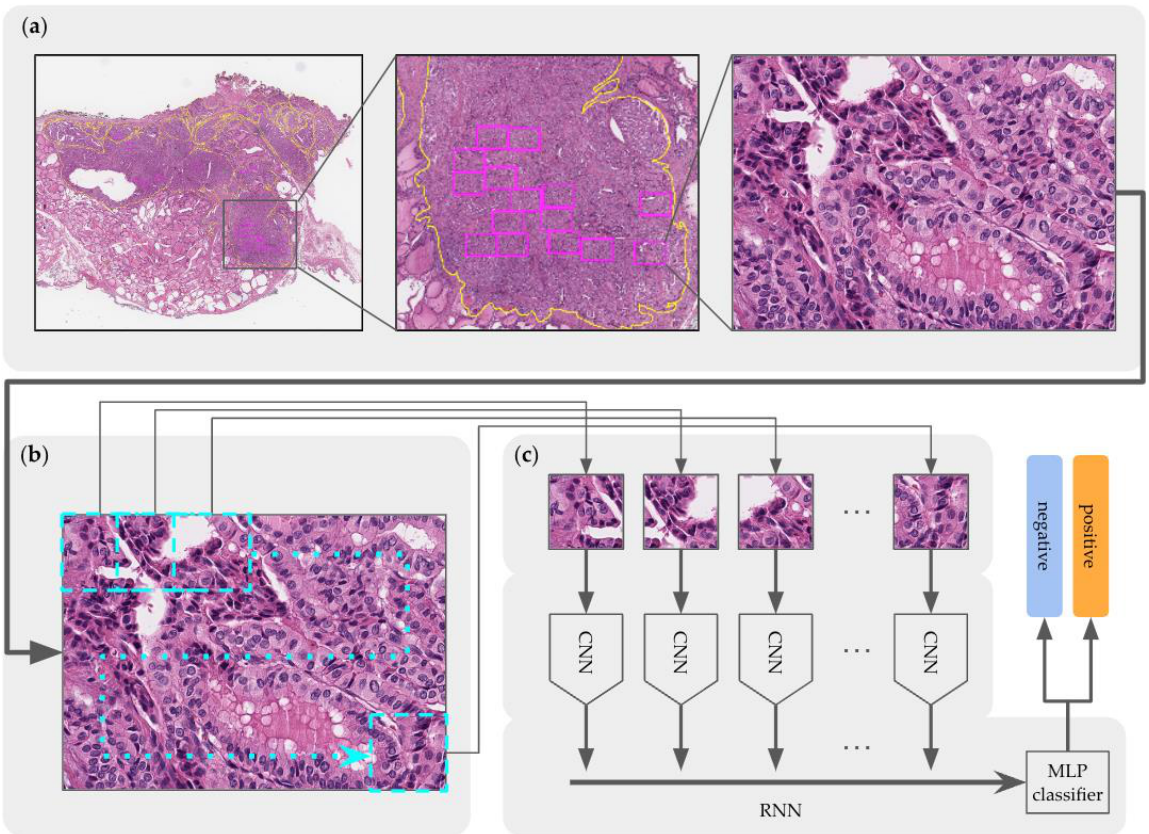
Figure 6. Overview of the CRNN training model architecture for TERT mutation prediction containing modules for: ( a ) TERT ROI bounding-box extraction, ( b ) tiling to 256 × 256 patches, and ( c ) CRNN.